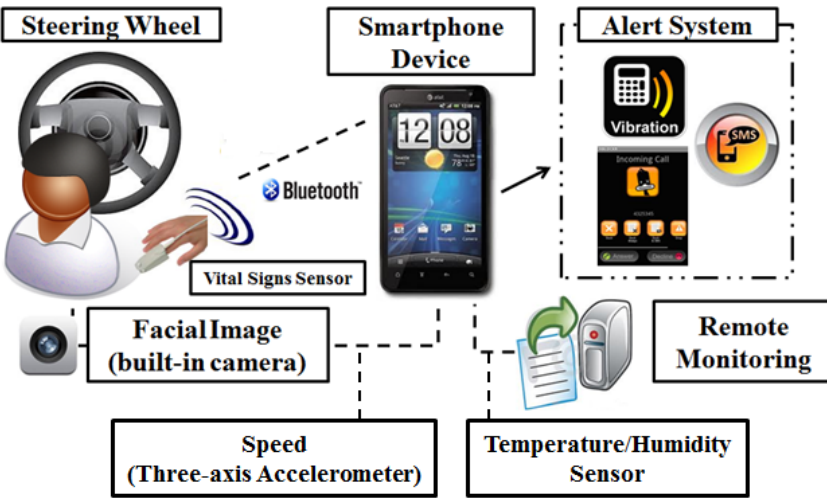
Figure 1. System design overview consists of several modules where smartphone device receives data from ECG, PPG and humidity sensors that placed on the steering wheel. Driver facial image is captured via smartphone front camera and vehicle speed is calculated with built-in three-axis accelerometer. Alert system is triggered if prediction vigilance index reached over 75 (0 is lowest and 100 is